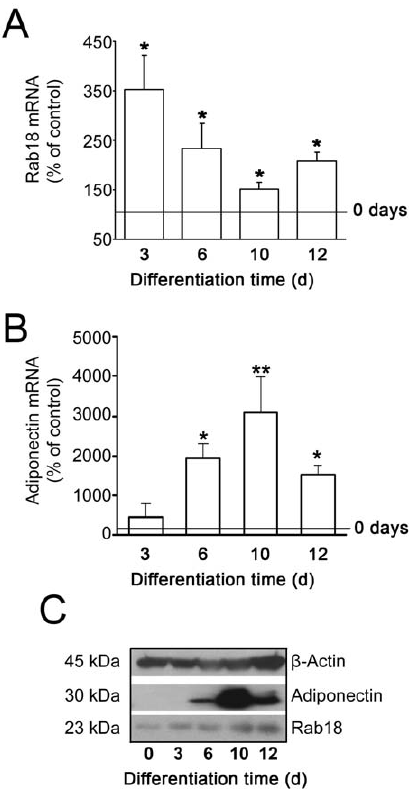
Figure 1. Rab18 expression during differentiation of 3T3-L1 cells into adipocytes. (A) Quantitative RT-PCR analysis of Rab18 mRNA levels in 3T3-L1 cells exposed to a hormonal differentiation cocktail for 0, 3, 6, 10 and 12 days. Gene expression was expressed as the ratio of target gene concentration to the concentration of a housekeeping gene, the 18S rRNA (2.0 6 10 8 6 7.7 6 10 7 and 3.2 6 10 13 6 2.2 6 10 12 Rab18 and 18S cDNA copies, respectively, per 0.1 m g total RNA in non-differentiated cells). Three independent experiments 6 SEM were tested for significance using the Newman-Keul’s comparison test. *, P , 0.05 vs. non-differentiated cells. (B) To monitor adipogenesis, adiponectin mRNA transcripts (1.6 6 10 8 6 1.3 6 10 8 cDNA copies/0.1 m g total RNA in non- differentiated cells) werealso quantified. (C)Representative immunoblots from 3 independent analyses of Rab18 and adiponectin protein content in 3T3-L1 cell extracts during differentiation. b -actin immunosignal was used as reference for protein charge.